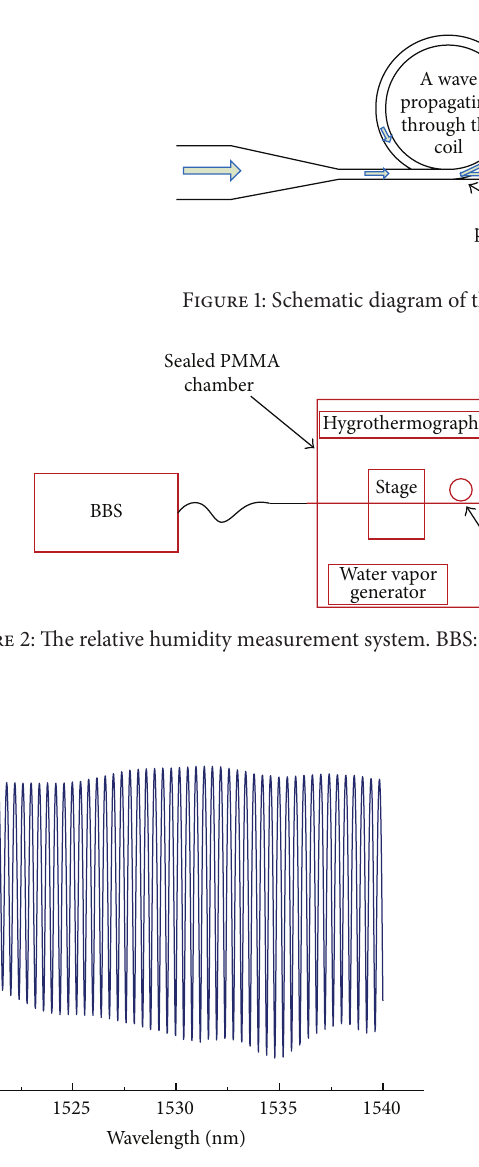
Figure 3: Measured transmission spectrum of the MLR.